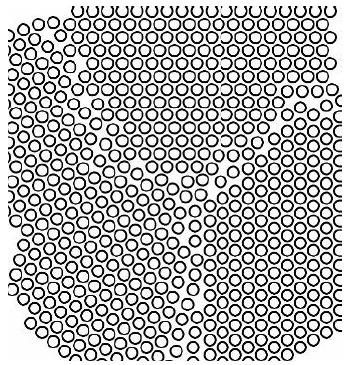
Figure 8. Illustration of grains and relative boundaries in a crystal.